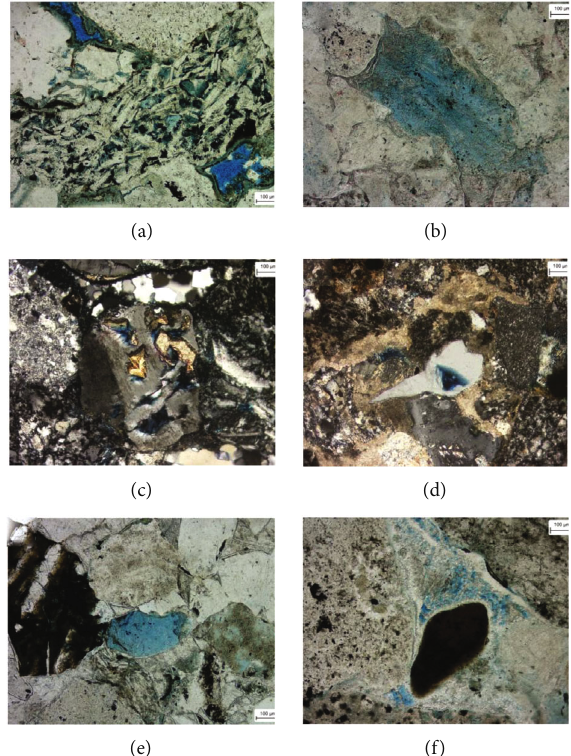
Figure 4: (a) Dissolved pores in the andesite cuttings, the pores are lined with chlorite to surround the intergranular pores, and the pores are fi lled with microcrystalline quartz, well B202, 3112.75m (-). (b) Acid erupted rock cuttings dissolve to form mold holes, well B210, 3948.60m (-). (c) Feldspar pores, B210 well, 3950.9m (+). (d) Quartz pores, B210 well, 4129.95m (+). (e) mold hole, B202 well, 3130.8m (-). (f) Lautonite cement dissolution pores, well B210, 3945.95m